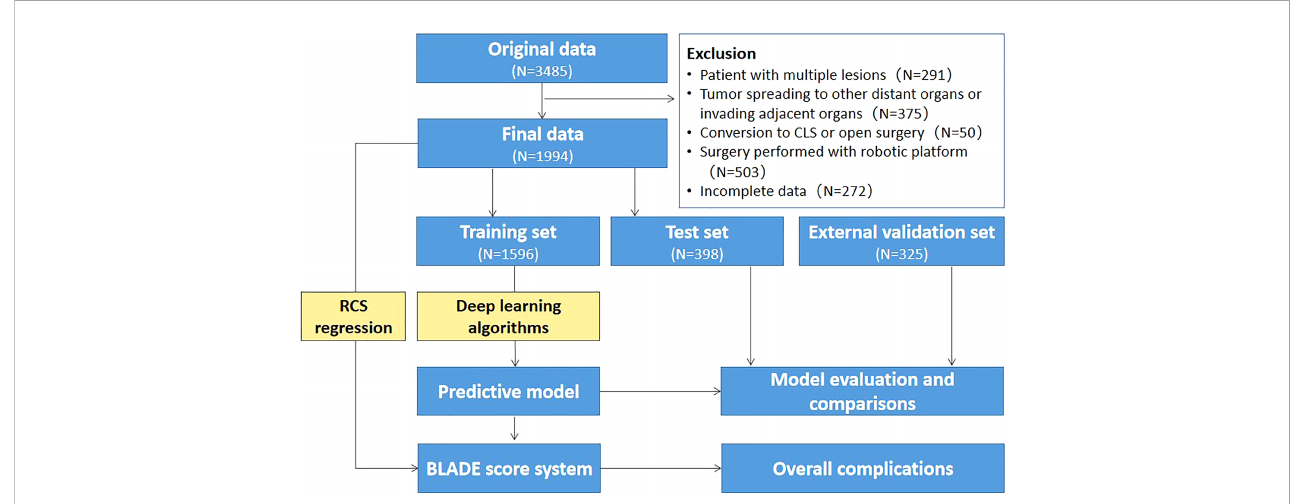
FIGURE 1 Flowchart illustrating patient selection and the overall data analysis procedures. RCS, restricted cubic spline; BLADE, blood loss and duration of excision; LR, logistic regression; CLS, conventional laparoscopic